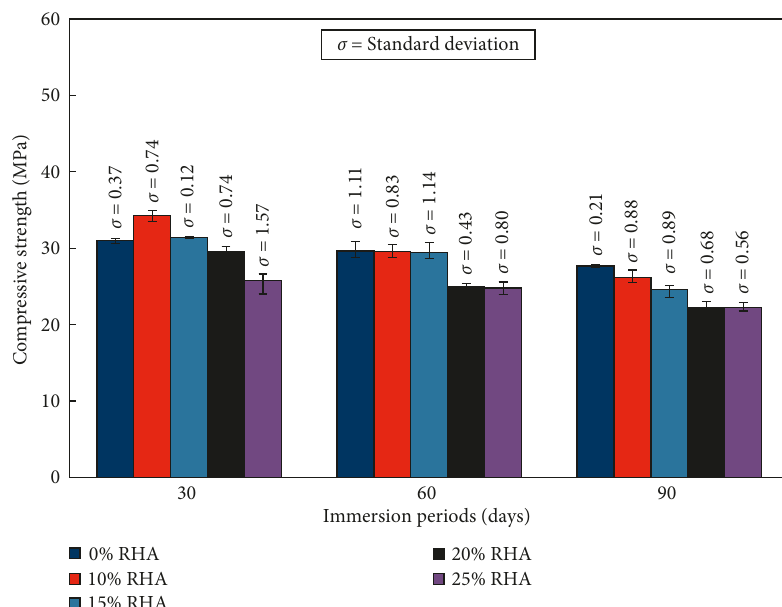
Figure 9: Compressive strength of RBAC immersed in MgSO